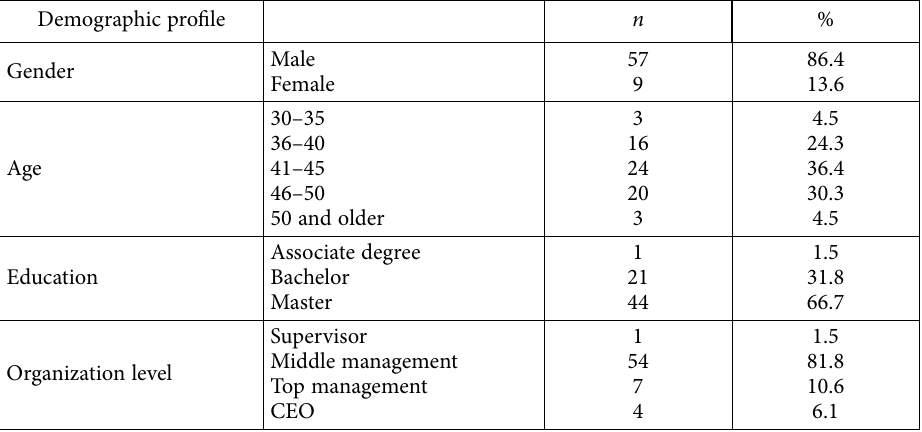
Table A1. Demographic characteristics of respondents